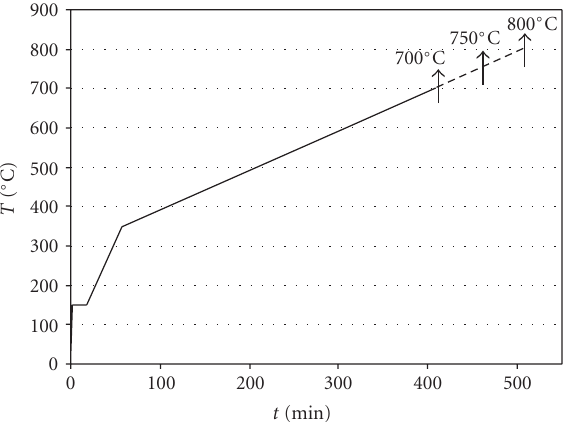
Figure 2: Heating procedure to prepare carbon membranes based in literature [6,